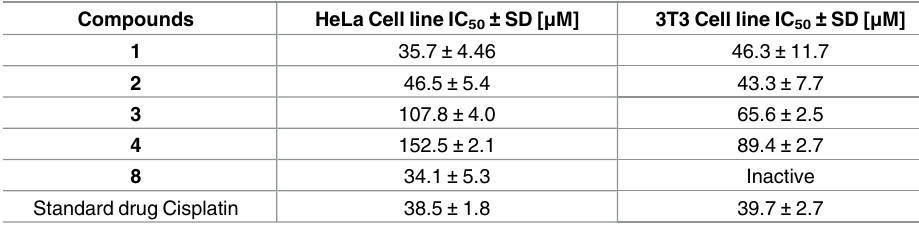
Table 5. Cytotoxicity of mibolerone (1), and its